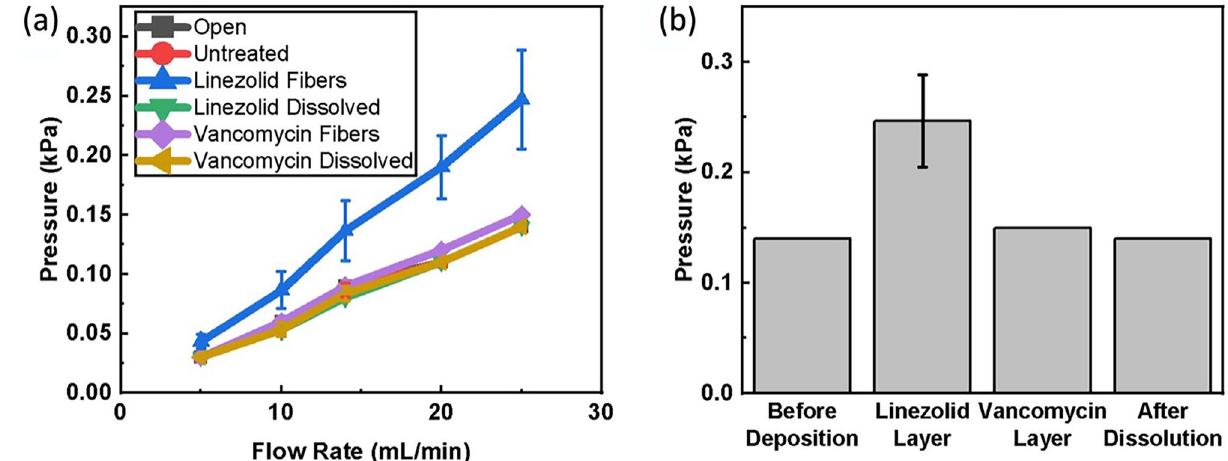
Figure 4. Porosity characterization of ozone dressing with and without drug eluting NFs coating. ( a ) Internal flow resistance at varying flowrates for dressing at different stages of application. ( b ) Comparison of internal flow resistance at 25 mL/min. Error bars denote standard